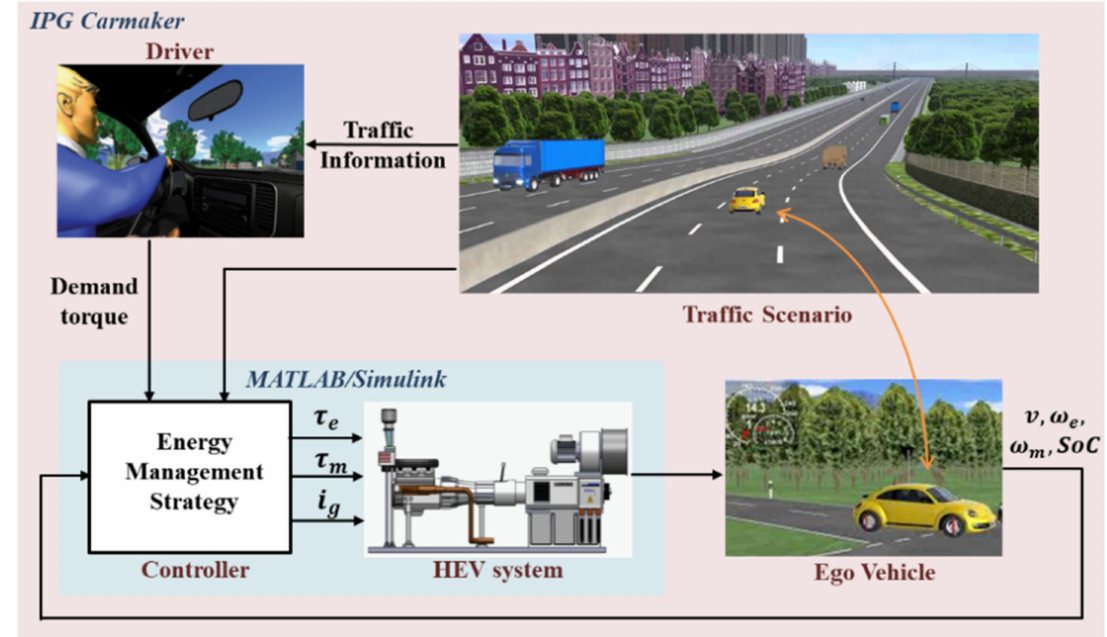
Figure 4. Simulation structure on IPG CarMaker and MATLAB/Simulink.